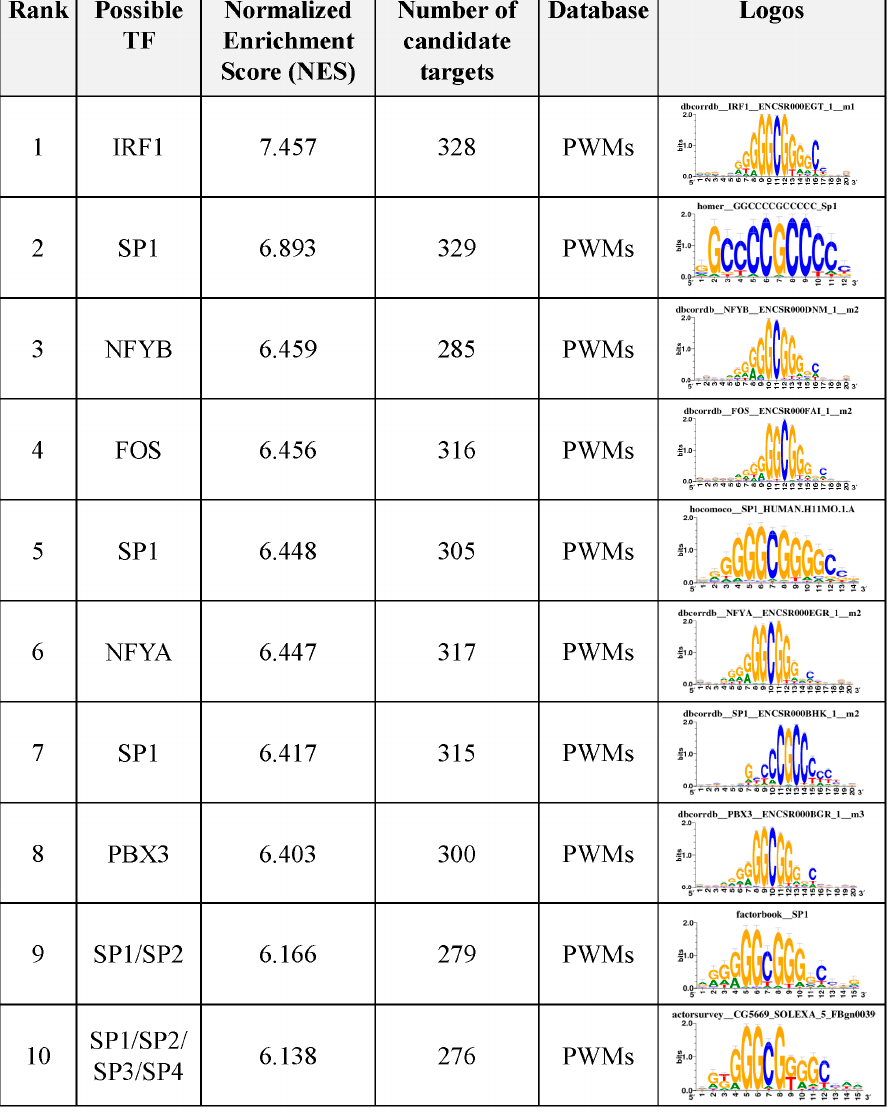
Figure 4. Top 10 motif enrichment discovery results on weaning differentially accessible regions, including TFs, target genes, and logos.